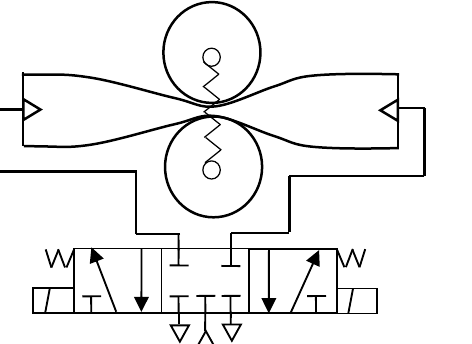
Figure 4. Pneumatic circuit used to impose back and forth motion to the actuator.